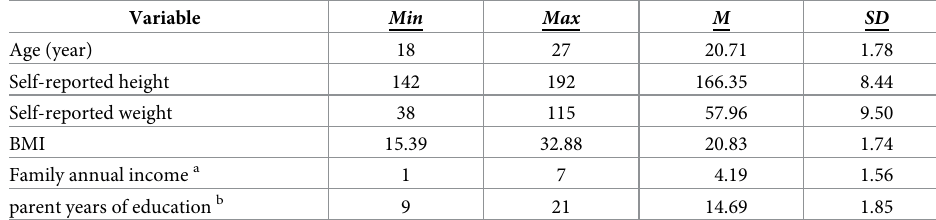
Table 1. The socio-demographic characteristics of